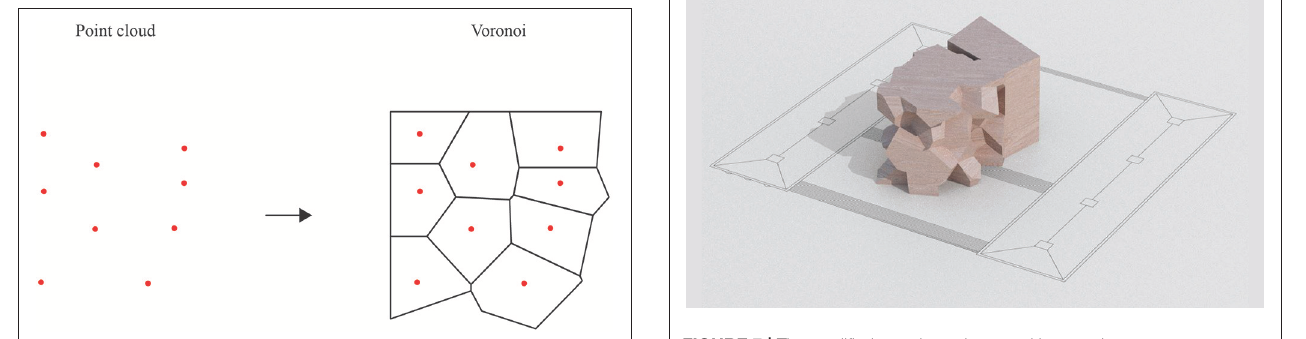
FIGURE 6 | Voronoi tessellation.